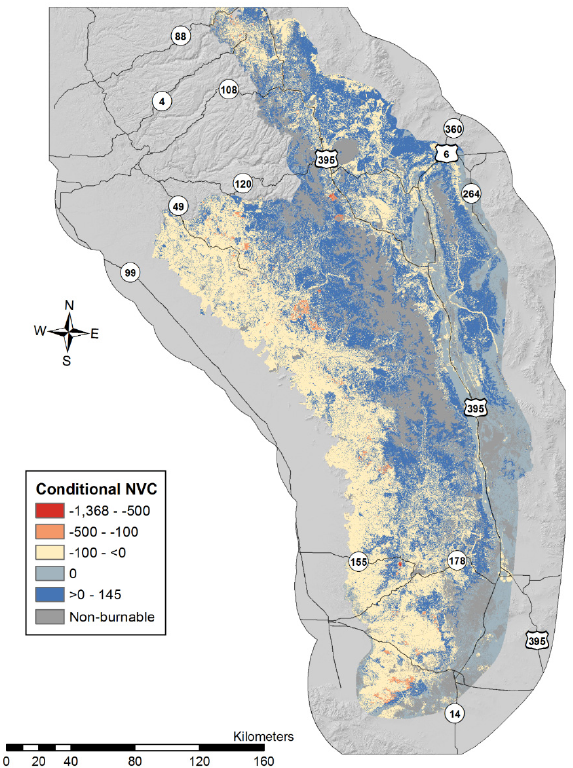
Figure 8. Geospatial distribution of conditional net value change (cNVC) for all HVRAs in the Southern Sierra Risk